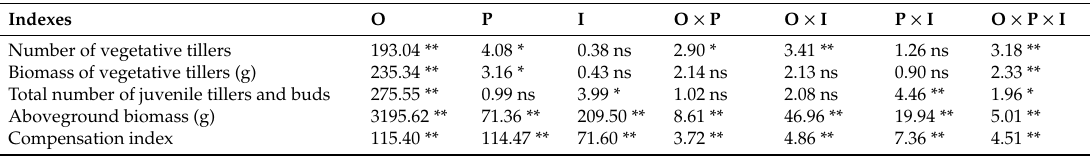
Table 1. Summary of three-way ANOVA analyses for the e ff ects of ontogenic stages (O), phenological periods (P), and clipping intensities (I) on the characteristics of H. brevisubulatum